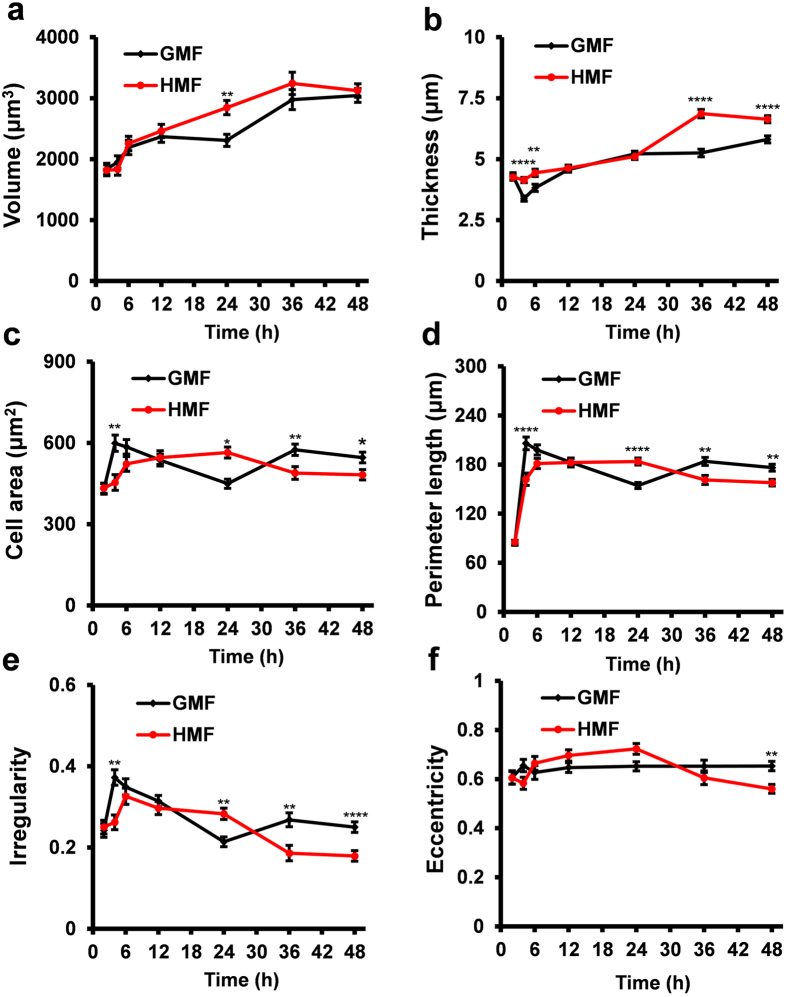
Morphological parameters of the HMF-exposed cells.Cell morphology parameters of SH-SY5Y cells, including cell volume (a), thickness (b), area (c), perimeter length (d), irregularity (e) and eccentricity (f) were measured using holographic imaging at 2, 4, 6, 12, 24, 36 and 48 h during exposure to the HMF or GMF. The volume of the HMF-exposed cell was larger than the GMF control at 24 h (a). The HMF-exposed cells were thicker than the controls at 4–6 h and 36–48 h (b). The HMF-exposed cells have larger cell areas and perimeter lengths at 24 h and smaller at 4 h and 36–48 h, as compared to the controls (c,d). The irregularity of the HMF-exposed cells increased at 24 h but decreased at 4 h and 36–48 h when compared to the control (e). The eccentricity of the HMF-exposed cells was decreased at 48 h (f). Data from three independent experiments are shown as mean ± s.e.m. The P values were calculated using a one-way ANOVA. *P < 0.05, **P < 0.01, ****P < 0.0001.